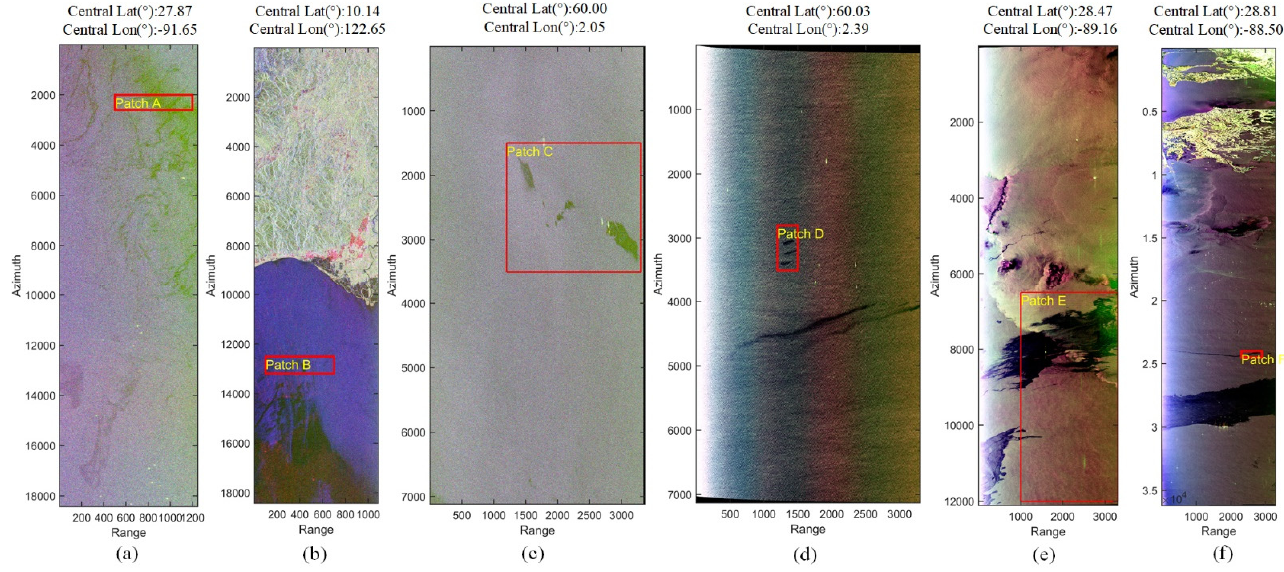
Figure 2. Pauli RGB images of the study area: ( a ) case 1; ( b ) case 2; ( c ) case 3; ( d ) case 4; ( e ) case 5; ( f ) case 6.